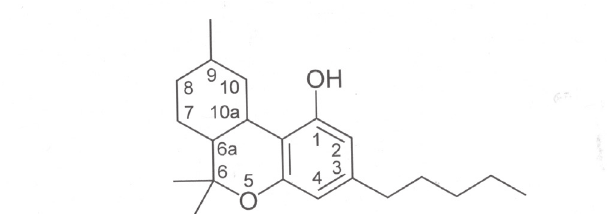
FIGURE 2 - The general structure of cannabinoids. Cannabinoids are terpene-phenolic compounds with 21 carbons, with a ring from the geranyl-pyrophosphate, and formed of three unique rings: tetrahydropyran, cyclohexane, and benzene. TABLE III - Sub-types of cannabinoids (120 compounds) (Abbreviated from Radwan et al. ,